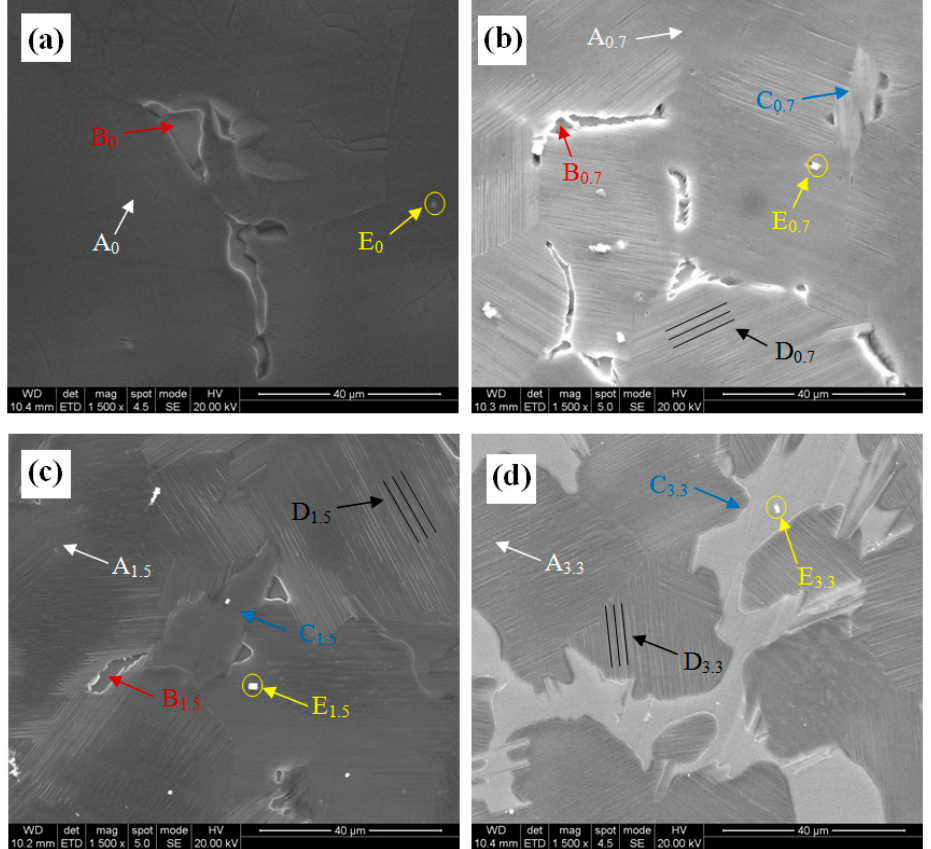
Figure 2. SEM images of the experimental alloys: ( a ) 0Zn, ( b ) 0.7Zn, ( c ) 1.5Zn, and ( d ) 3.3Zn.